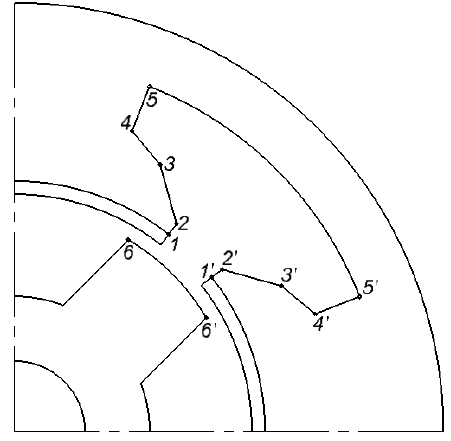
Figure 5. Indication of some geometrical parameters.